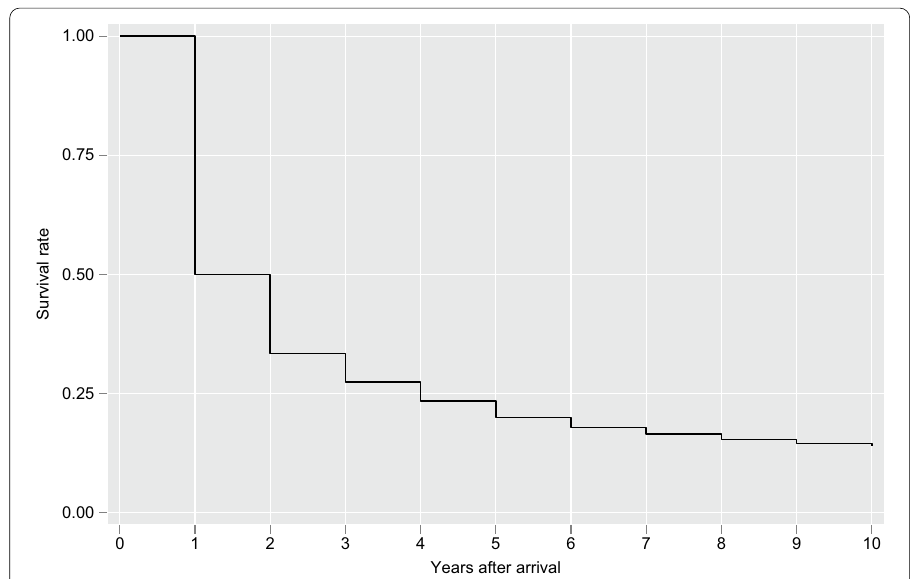
Fig. 3 Kaplan–Meier survival function of not being registered for immigrants arrived in the period 2000–2006